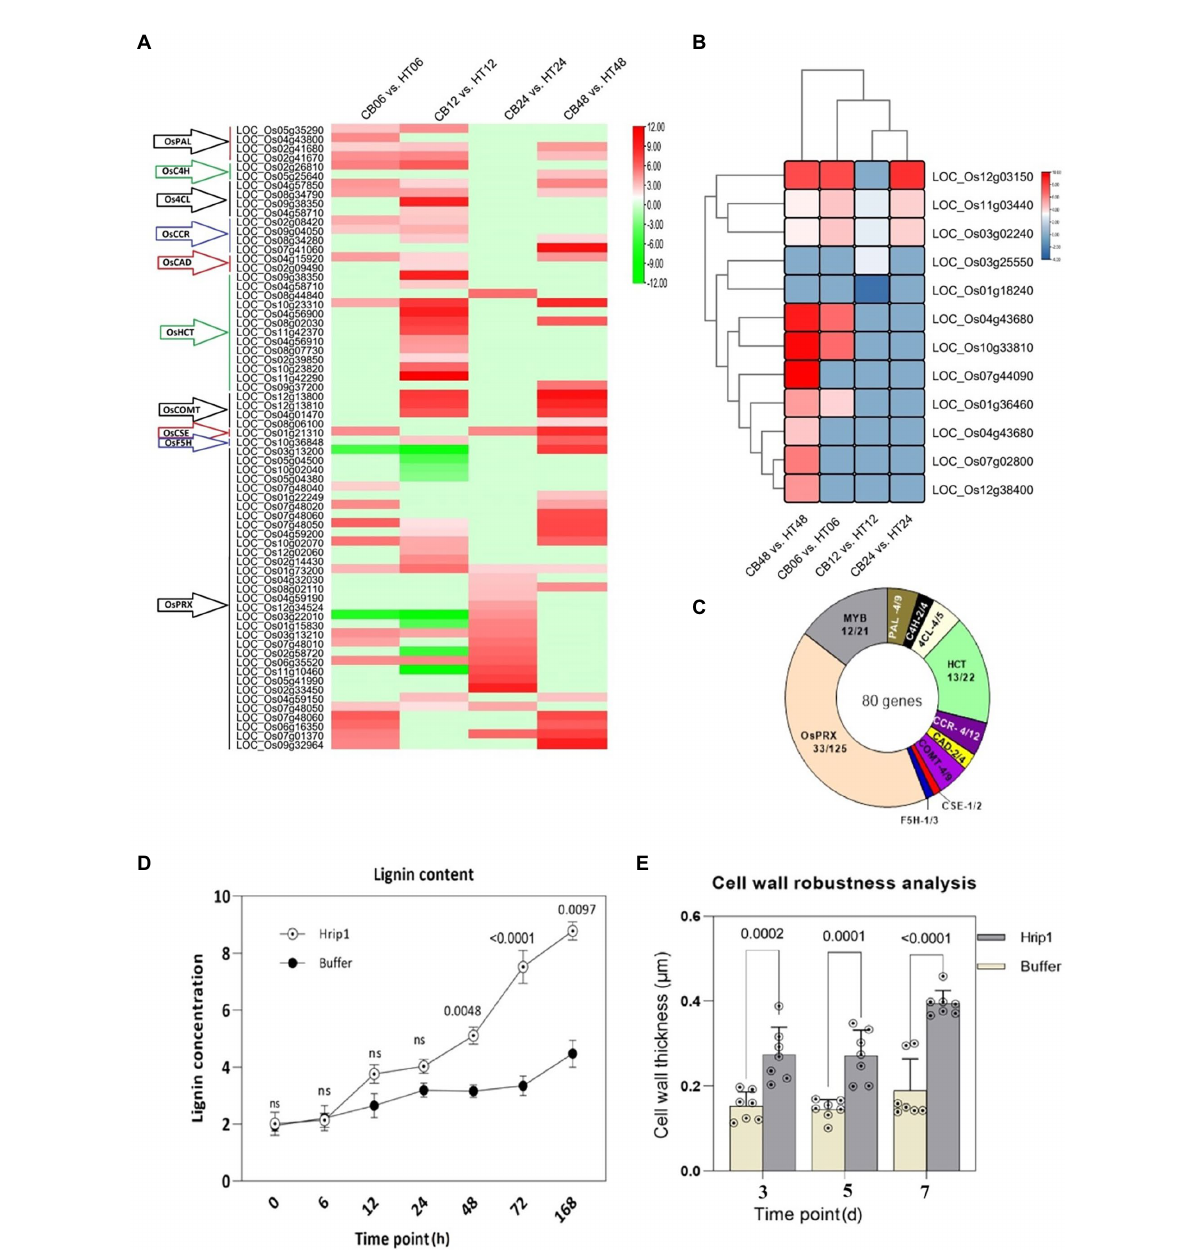
FIGURE 2 Lignin biosynthetic genes and transcriptional factors activated after Hrip1 treatment. (A) Expression profile of Hrip1-treated lignin biosynthetic genes, heat maps represent log2 (fold) values from the transcriptome results. Each time point represents a pairwise comparison between treatment and control. The gene families are indicated with arrows to the left: Phenylalanine ammonia-lyase (PAL), Cinnamate-4-hydroxylase (C4H), 4-hydroxycinnamoyl-CoA ligase (4CL), Hydroxycinnamoyl transferase (HCT), Cinnamoyl CoA reductase (CCR), Cinnamoyl alcohol dehydrogenase (CAD), Ferulate 5-hydroxylase (F5H), Caffeic acid 3- O -methyltransferase (C O MT), Caffeoyl shikimate esterase (CSE), and Peroxidase (PRX). (B) Neighbor-joining phylogeny of induced lignin biosynthetic genes. (C) Clustering and expression pattern of MYB transcription factor. Statistics of all Hrip1-treated genes associated with lignin metabolism and polymerization compared with the rice genome. (D) Lignin content analysis ( n = 2). (E) Cell wall thickness analysis ( n =